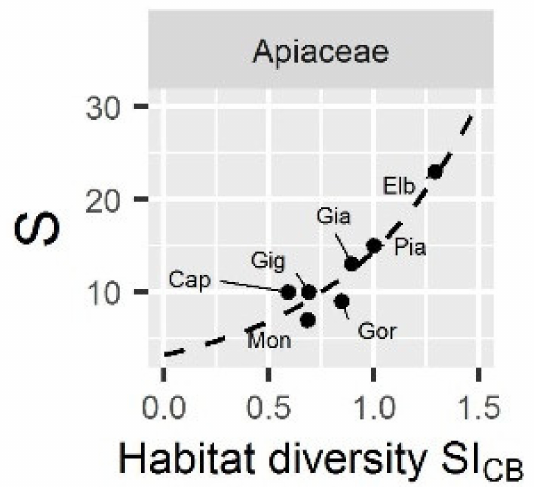
Figure 4. Habitat Diversity Hypothesis (HDH) according to island habitat diversity: effect of habitat diversity (SI CB : Shannon’s Index on CORINE Biotopes) on species richness (S) of Apiaceae in the Tuscan Archipelago.